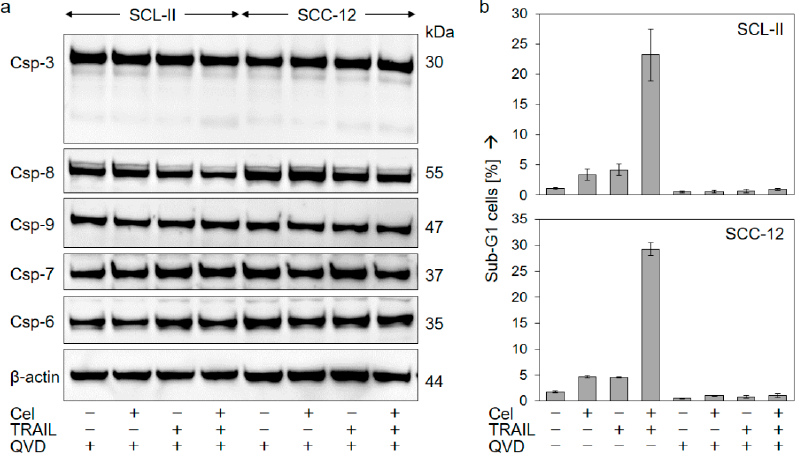
Figure 6. Inhibition of apoptosis by a caspase inhibitor. SCL-II and SCC-12 were treated for 24 h with celecoxib (50 µM), TRAIL (50 ng/mL), or the combination. In addition, cells received the pan-caspase inhibitor QVD-Oph (10 µM) at 1 h before other treatments started. ( a ) Protein extracts were analyzed by Western blotting for caspase activation (processing). Equal protein amounts (30 µg per lane) were separated by SDS-PAGE, and consistent blotting was proven by Ponceau staining as well as by evaluation of β -actin expression. Molecular weights (in kDa) of caspase proforms are indicated. Two independent series of protein extracts and independent Western blots revealed highly comparable results. ( b ) Apoptosis was determined at 24 h of treatment by cell cycle analysis and quantification of sub-G1 cells (mean values +/ − SDs of representative experiments). Two independent experiments, each one with triplicate values, showed the same